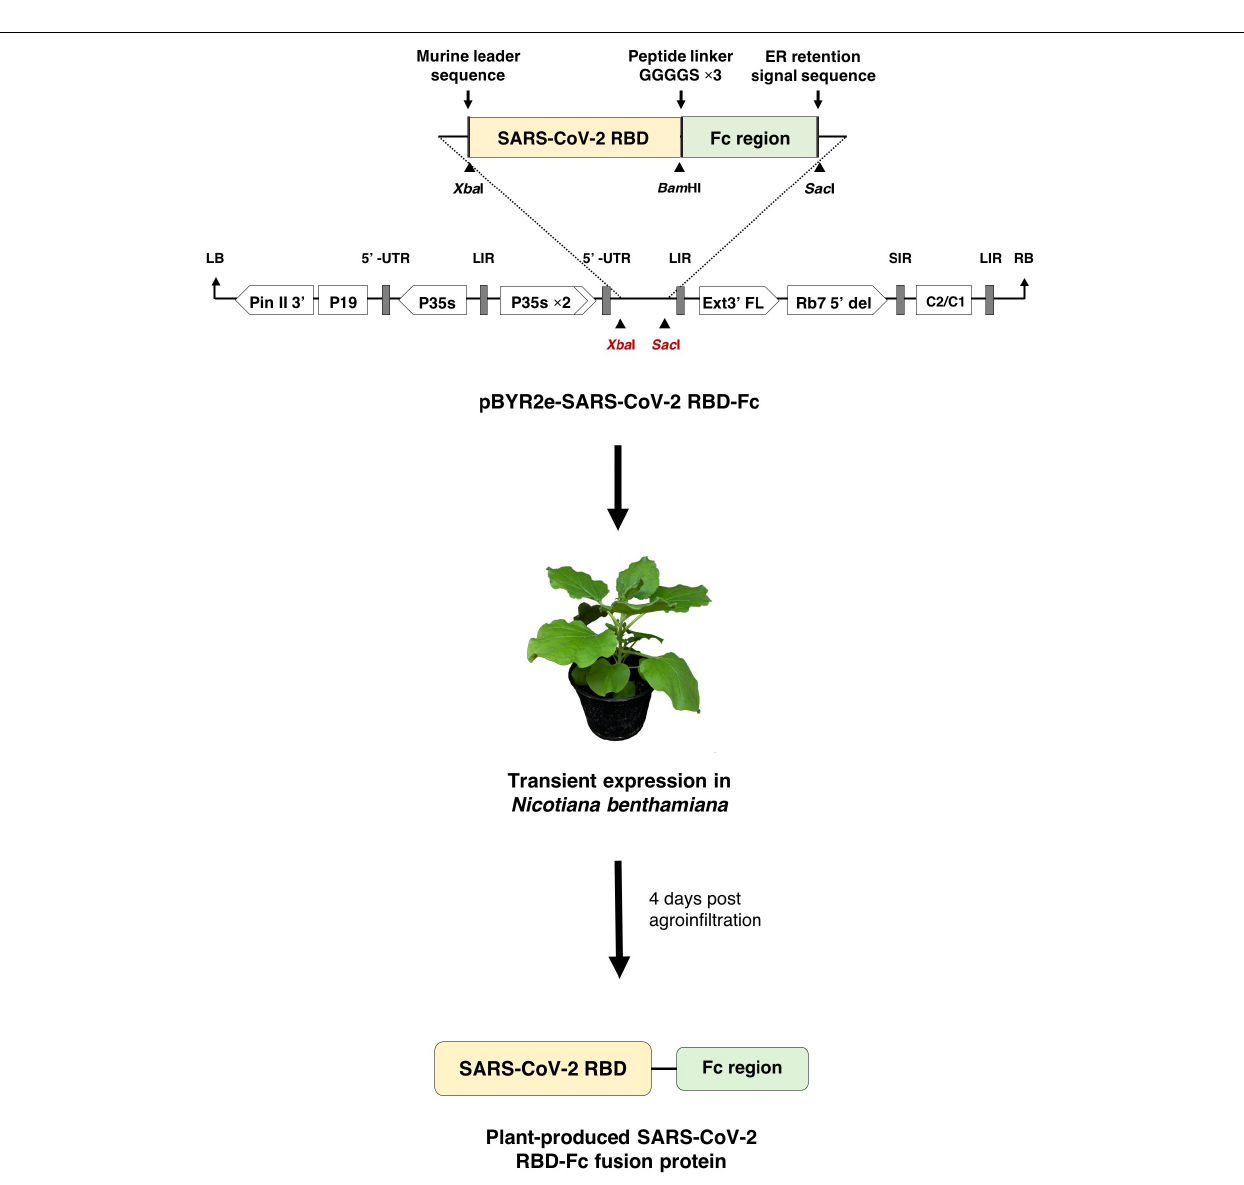
cells by electroporation (MicroPulser, Bio-Rad, United